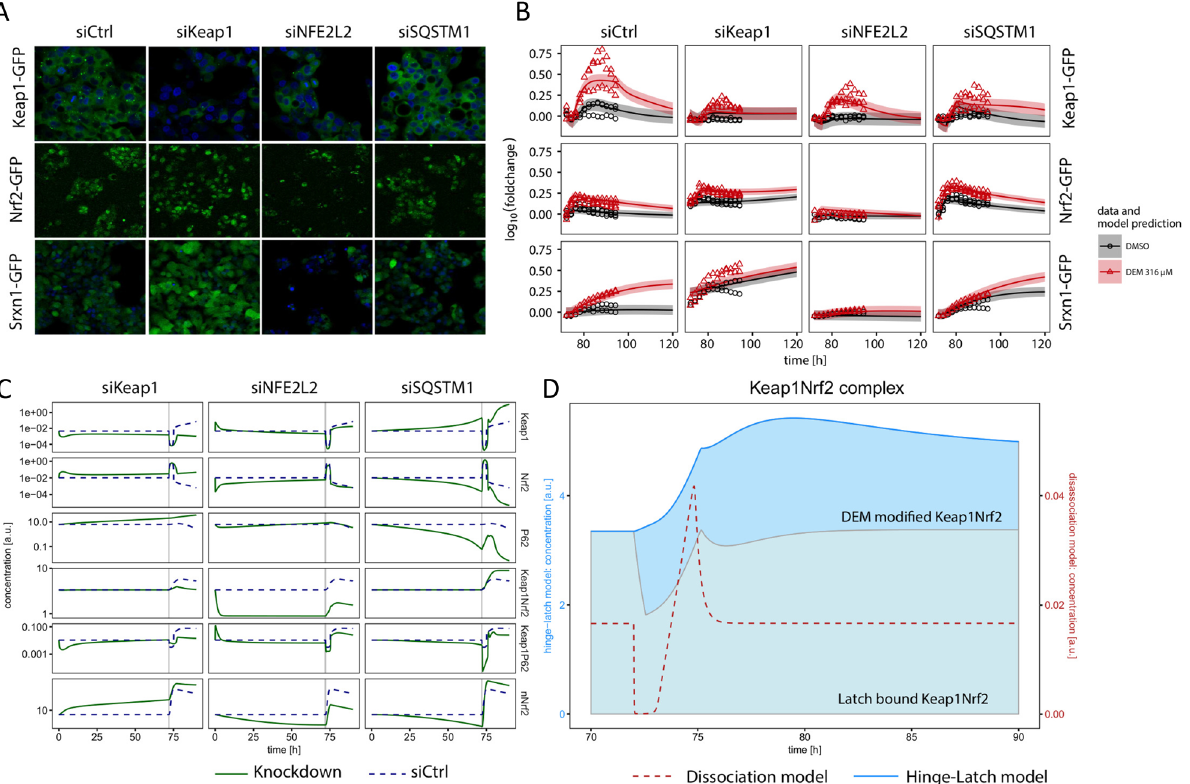
Figure 3. Dynamics after knock down of Keap1, NFE2L2 and SQSTM1 in the Srxn1-GFP, Keap1-GFP and Nrf2-GFP reporter cell lines. ( A ) Example images of Keap1-GFP, Nrf2-GFP and Srxn1-GFP for siCtrl, siKEAP1, siNFE2L2 and siSQSTM1 at the 24 h timepoint. The Hoechst stained nuclei are blue, the GFP signal is green. ( B ) Model prediction (lines) and data points (circles and triangles) for knock-down of siCtrl, siKEAP1, siNFE2L2 and siSQSTM1 in Keap1-GFP, Nrf2-GFP and Srxn1-GFP for DMSO control (black) and DEM 316 µ M treatment (red). Shaded areas indicate one standard deviation as estimated by the error model. The 72 h of knock-down before drug exposure are not shown. ( C ) Model prediction of the internal states Keap1, Nrf2, p62, Keap1p62, Keap1Nrf2 and nNrf2 for the hinge-latch (HL) model after knock down with siCtrl (dashed lines), siNFE2L2, siKEAP1 and siSQSTM1 (solid lines), including the first 72 h of knock-down simulation. At 72 h DEM 316 µ M was added (indicated with the vertical line). ( D ) Model prediction for the Keap1-Nrf2 complex for the hinge-latch (HL) model (solid line) and disassociation model (dashed line). The filled areas correspond to the two major model states in the HL-model contributing to the Keap1-Nrf2 complex, i.e., the latch bound Keap1-Nrf2 (Keap1 is bound to Nrf2 at both sites) and DEM modified Keap1-Nrf2 (Keap1 is bound to Nrf2 at only one site due to the modification of Keap1). Contributions to the Keap1-Nrf2 complex from other model states were found to be negligible. At 72 h DEM 316 µ M was